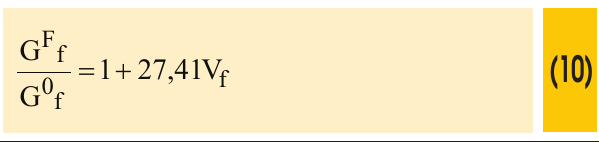
Model with bonding length equal to 10  (10 cm) A